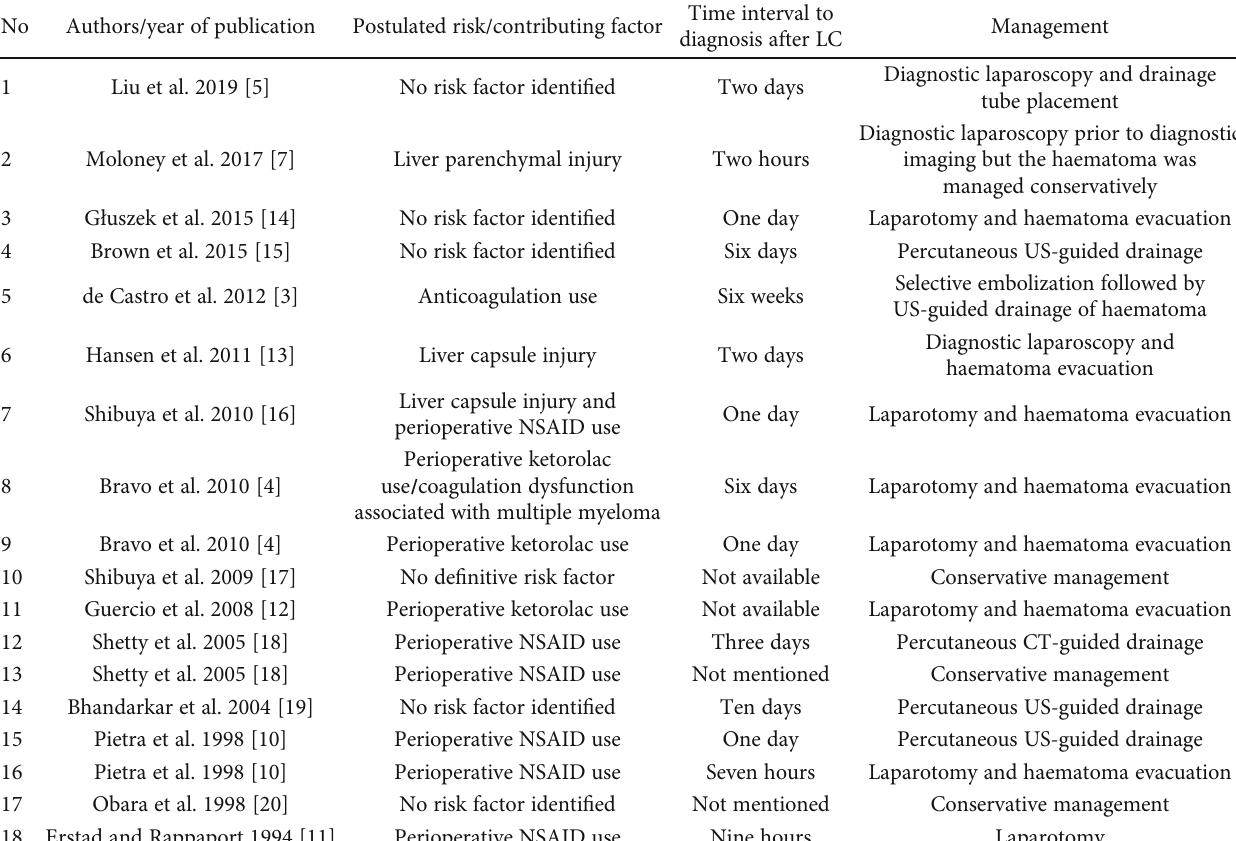
Table 1: Literature review of post-LC-ISH cases